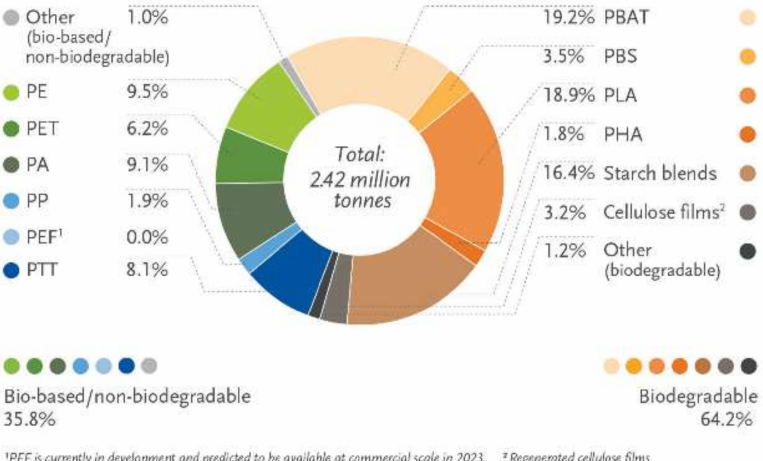
Figure 1. The global production of bioplastics by material types. Copyright European Bioplastics Nova-Institute (2021). Available online: https://www.european-bioplastics.org/news/publications/ #MarketData (accessed on 1 June 2022).